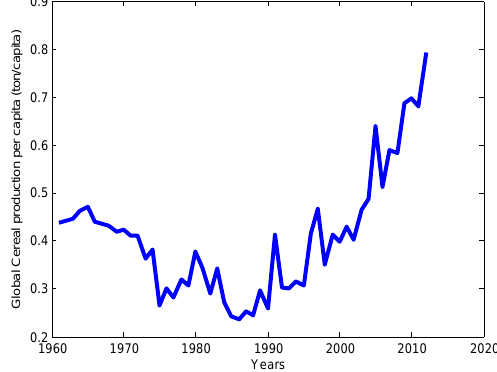
Figure 1. Global cereal production per capita (ton/capita) obtained by dividing global cereal production by global population (data source: http://faostat.fao.org/). Note that the population has been growing over the same time